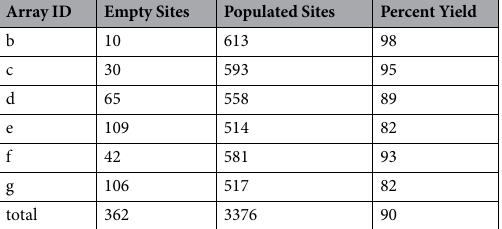
Table 1. Quantification of nanodiamond material coverage of six of the eight arrays indicated in Fig. 1. Each array was fabricated with 623 apertures developed in PMMA, and after deposition of nanodiamond material and removal of the photoresist, the yield was quantified by eye from SEM